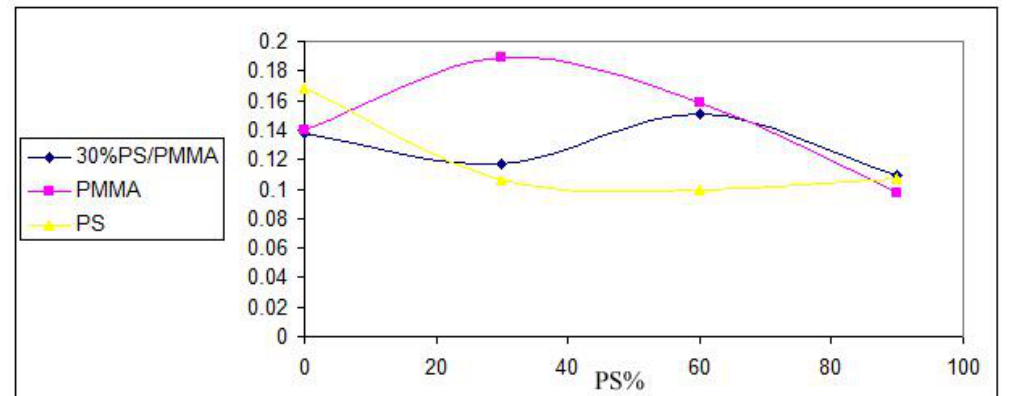
Fig.10: Thermal conductivity for (PMMA, PS and 30%PS), after UV - weathering for (30, 60, and 90 hr).